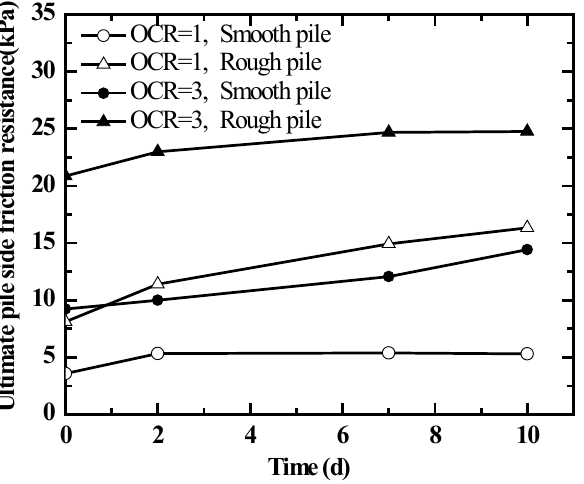
Figure 12. Curves of the ultimate pile side friction resistance of jacked pile varying with the resting phase.